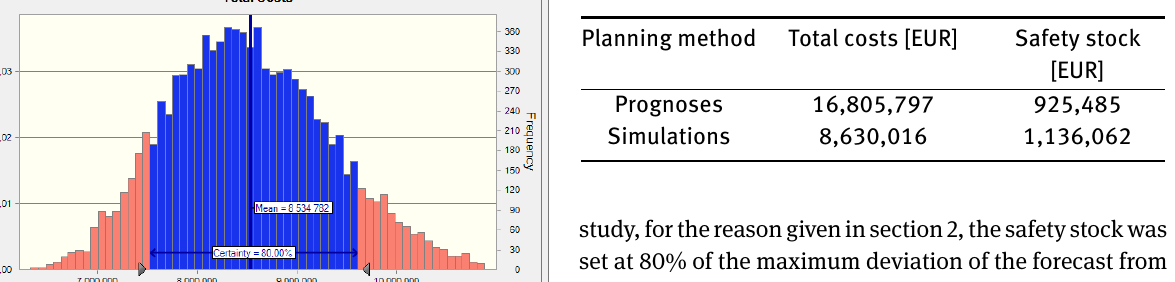
Table 8: Production costs and safety